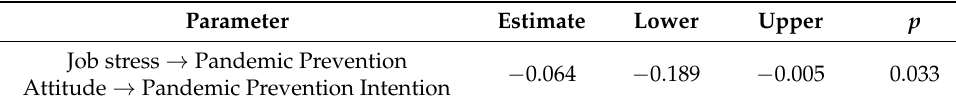
Table 6. The analysis of indirect effects.